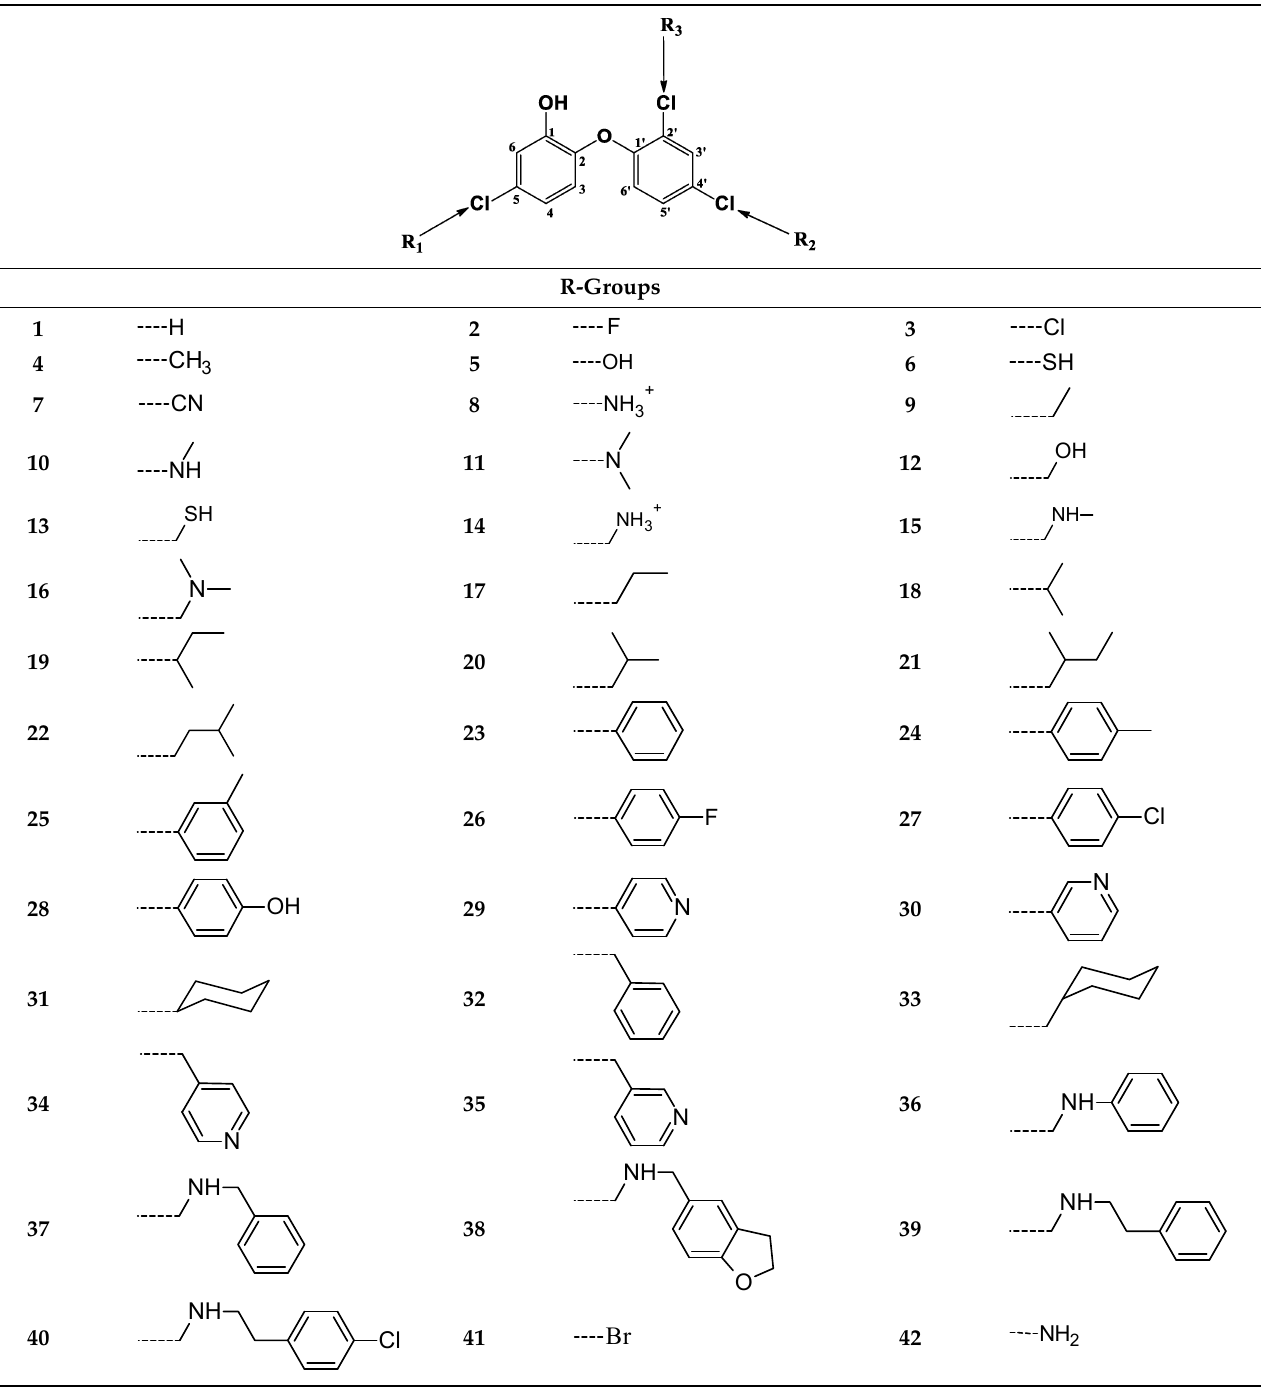
listed in the database of available chemicals [38]. Table 5. R 1 , R 2 and R 3 groups used in the design of the initial diversity library of TCL analogues. R ‐ Groups R ‐ Groups R ‐ Groups